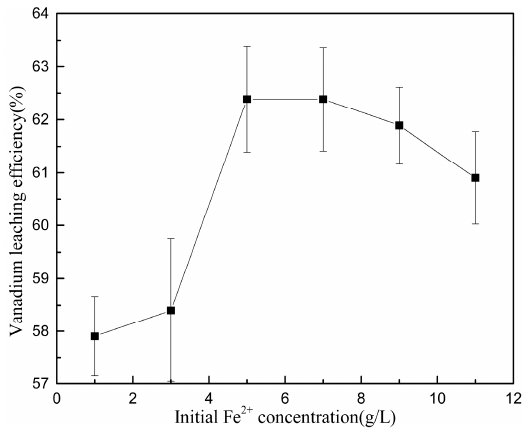
Figure 5. The highest vanadium leaching efficiency over time at different initial Fe 2+ concentrations.